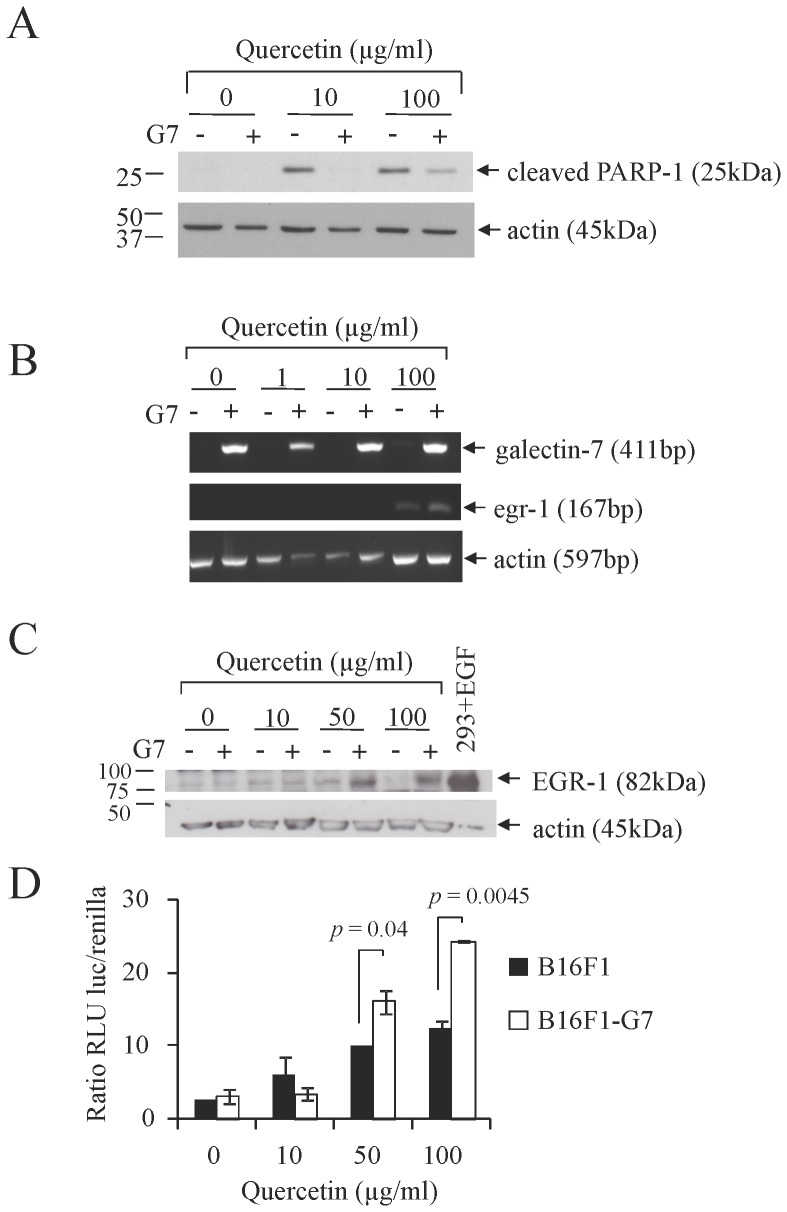
Effect of quercetin on B16F1 cells overexpressing galectin-7 on apoptosis and EGR-1 expression.B16F1 cells overexpressing galectin-7 (+) or controls (–) were treated with various doses of quercetin. A) Apoptotic sensitivity was analyzed by western blotting for cleaved PARP-1 detection. B) RT-PCR analysis of galectin-7 and EGR-1 mRNA expression. C) Western blot analysis for EGR-1 detection, 293 cells transfected with EGF were used as a positive control. Actin was used as a loading and specificity control. D) Dual luciferase assay of B16F1 transfectant cells overexpressing galectin-7 (□) or controls (▪) co-transfected with luciferase reporter plasmids with an EGR-1 promoter and pRLSV40-Renilla vector as a transfection control and treated with various doses of quercetin for 24 h. A mixture of three clones of B16F1-G7 was used (G7 #5, 10 and 14) for all of these experiments.